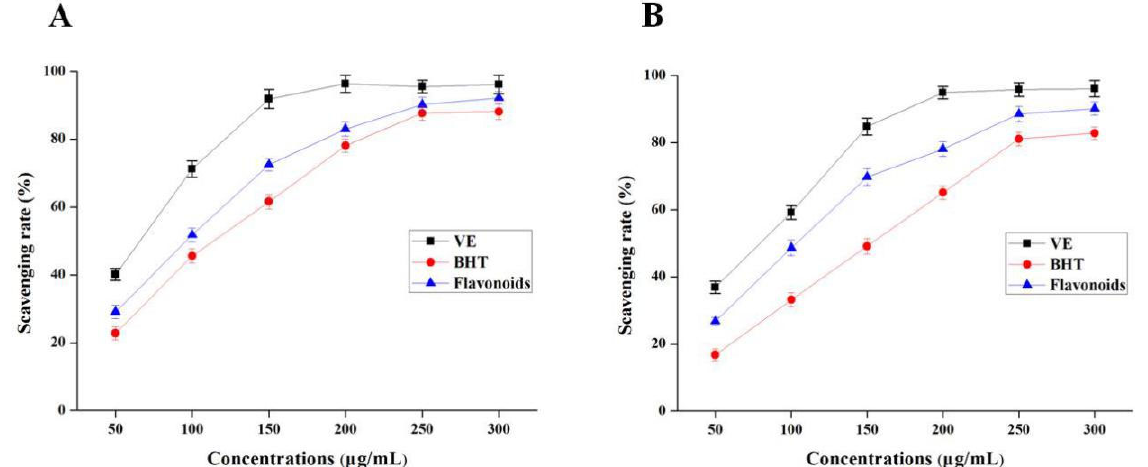
Figure 6. DPPH radical-scavenging activity ( A ) and O 2 − • radical -scavenging activity ( B ) of total flavonoid compounds in vitro. BHT, butylated hydroxytoluene; VE, vitamin E.